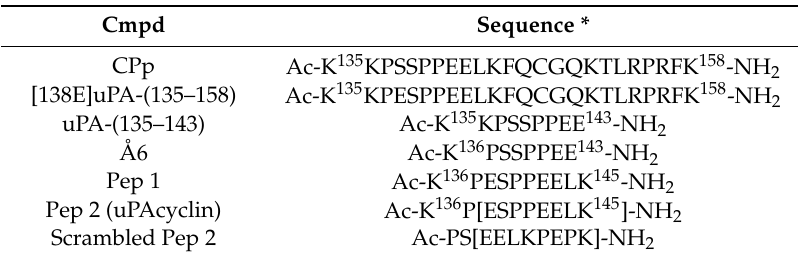
Table 1. Sequences of relevant peptides.